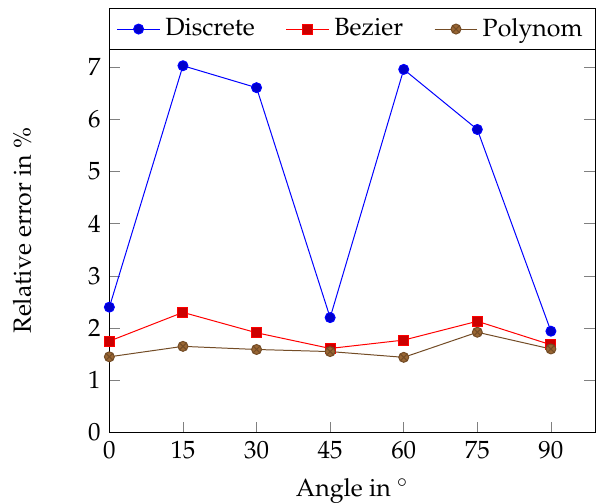
Figure 6. Relative length error using the erosion method in dependency on the angle for straight silicone tubes. The angle is measured to the horizontal pixel grid